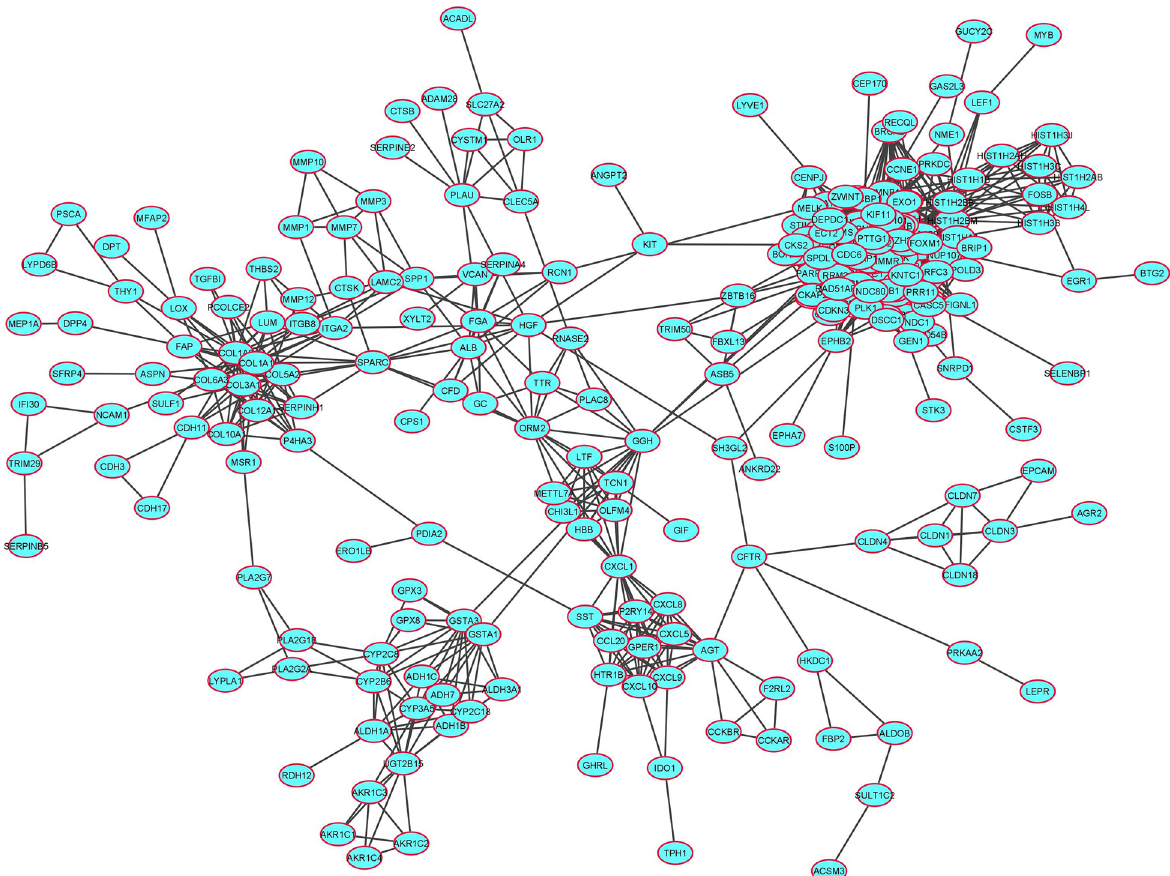
Fig. 3 The whole network giant component. Labels are protein/gene symbols. This is a scale-free network [13] that follows a power-law distribution (most network nodes have a low degree while there are few nodes with a high